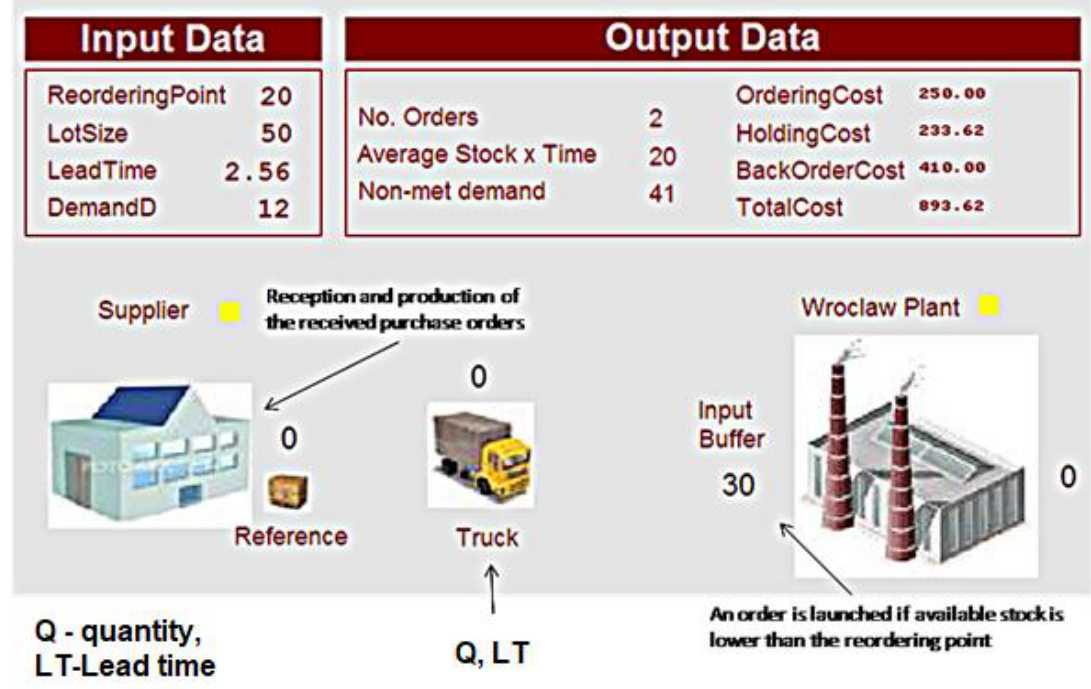
Figure 6. Graphical description of the reordering problem to be solved.